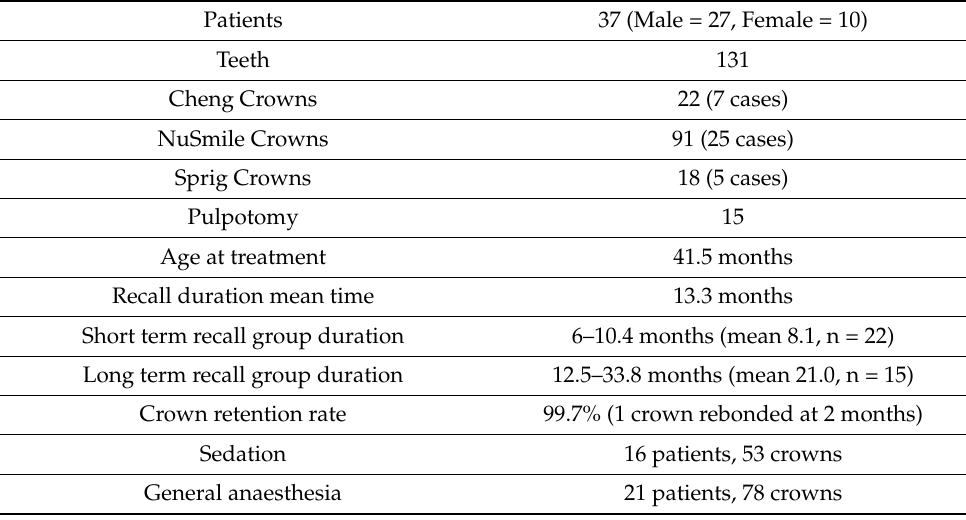
Table 2. Demographic data of study subjects.